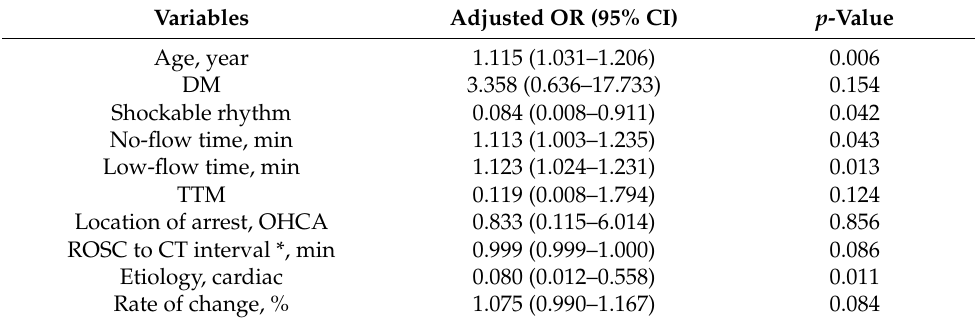
Table 3. Multivariable logistic regression analysis for poor neurologic outcome with baseline variables and rate of optic nerve sheath diameter change.